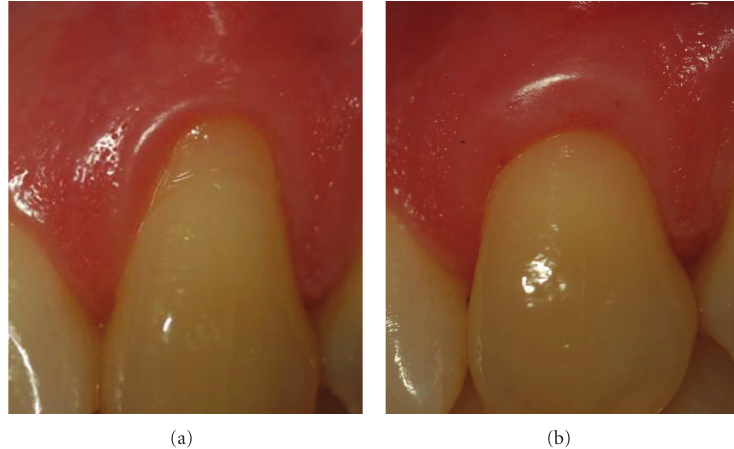
Figure 1: Left maxillary canine (patient #4): (a) before, (b) 3 months after connective tissue graft. The denuded root surface was covered completely. Gingiva is a bit too thick, but the color blends in perfectly.